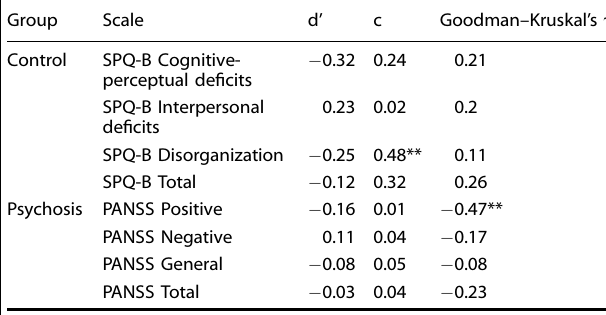
Table 1. Correlations between clinical measures and sensitivity, bias